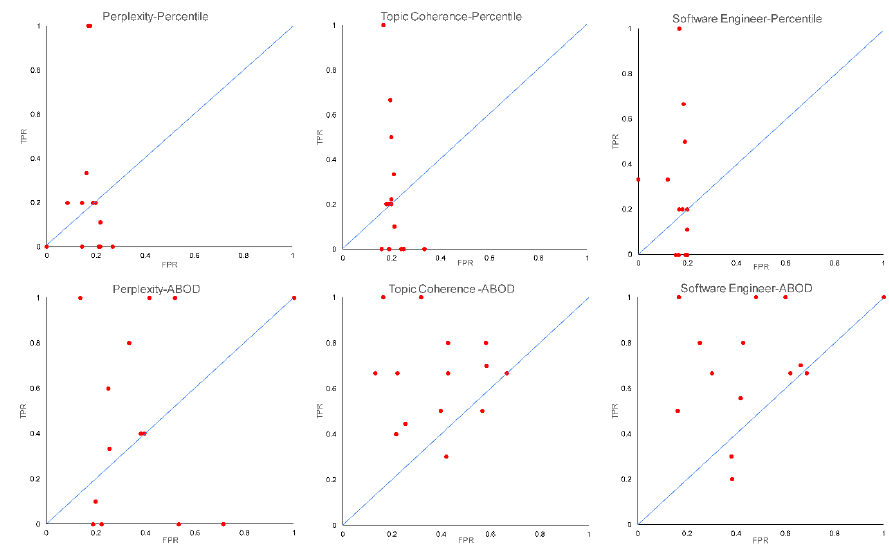
Figure 10. The ROC curve of the six models with different combinations of estimation approach and outlier detection